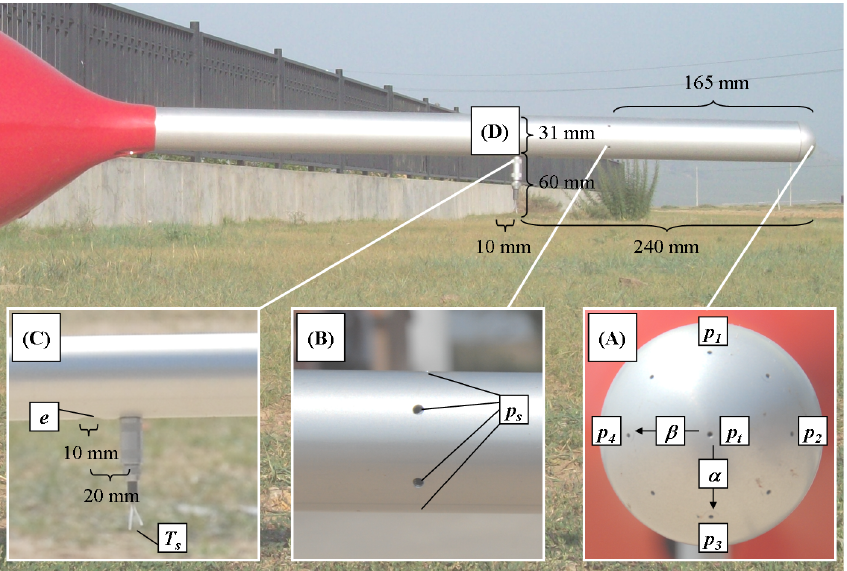
Fig. 3. Layout of the five hole probe, with letters indicating sensor locations. (A) The half sphere tip of the five hole probe, with ports for total- and differential pressure measurements. (B) Ports for static pressure measurement downstream of the half sphere. (C) Thermocouple and port for the capacitive humidity measurement. (D) Location of five hole probe 3-D acceleration sensor. Additional information is given in Sect. 2.2.